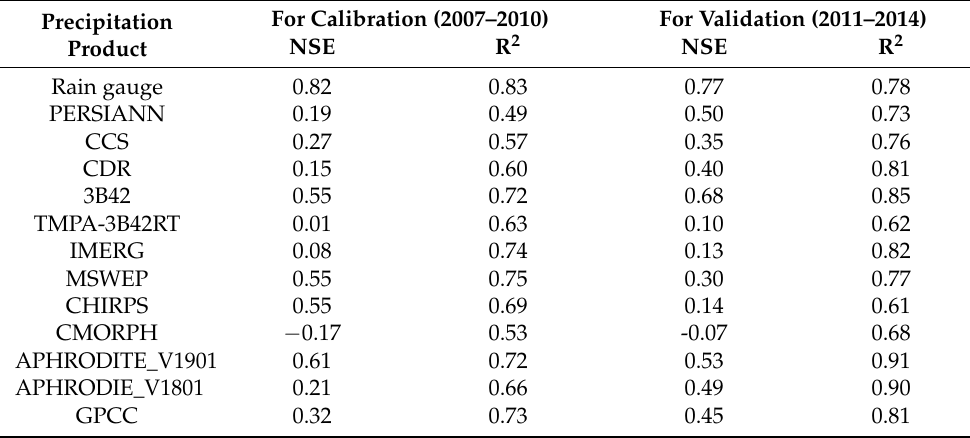
Table 3. Hydrologic performance of different precipitation